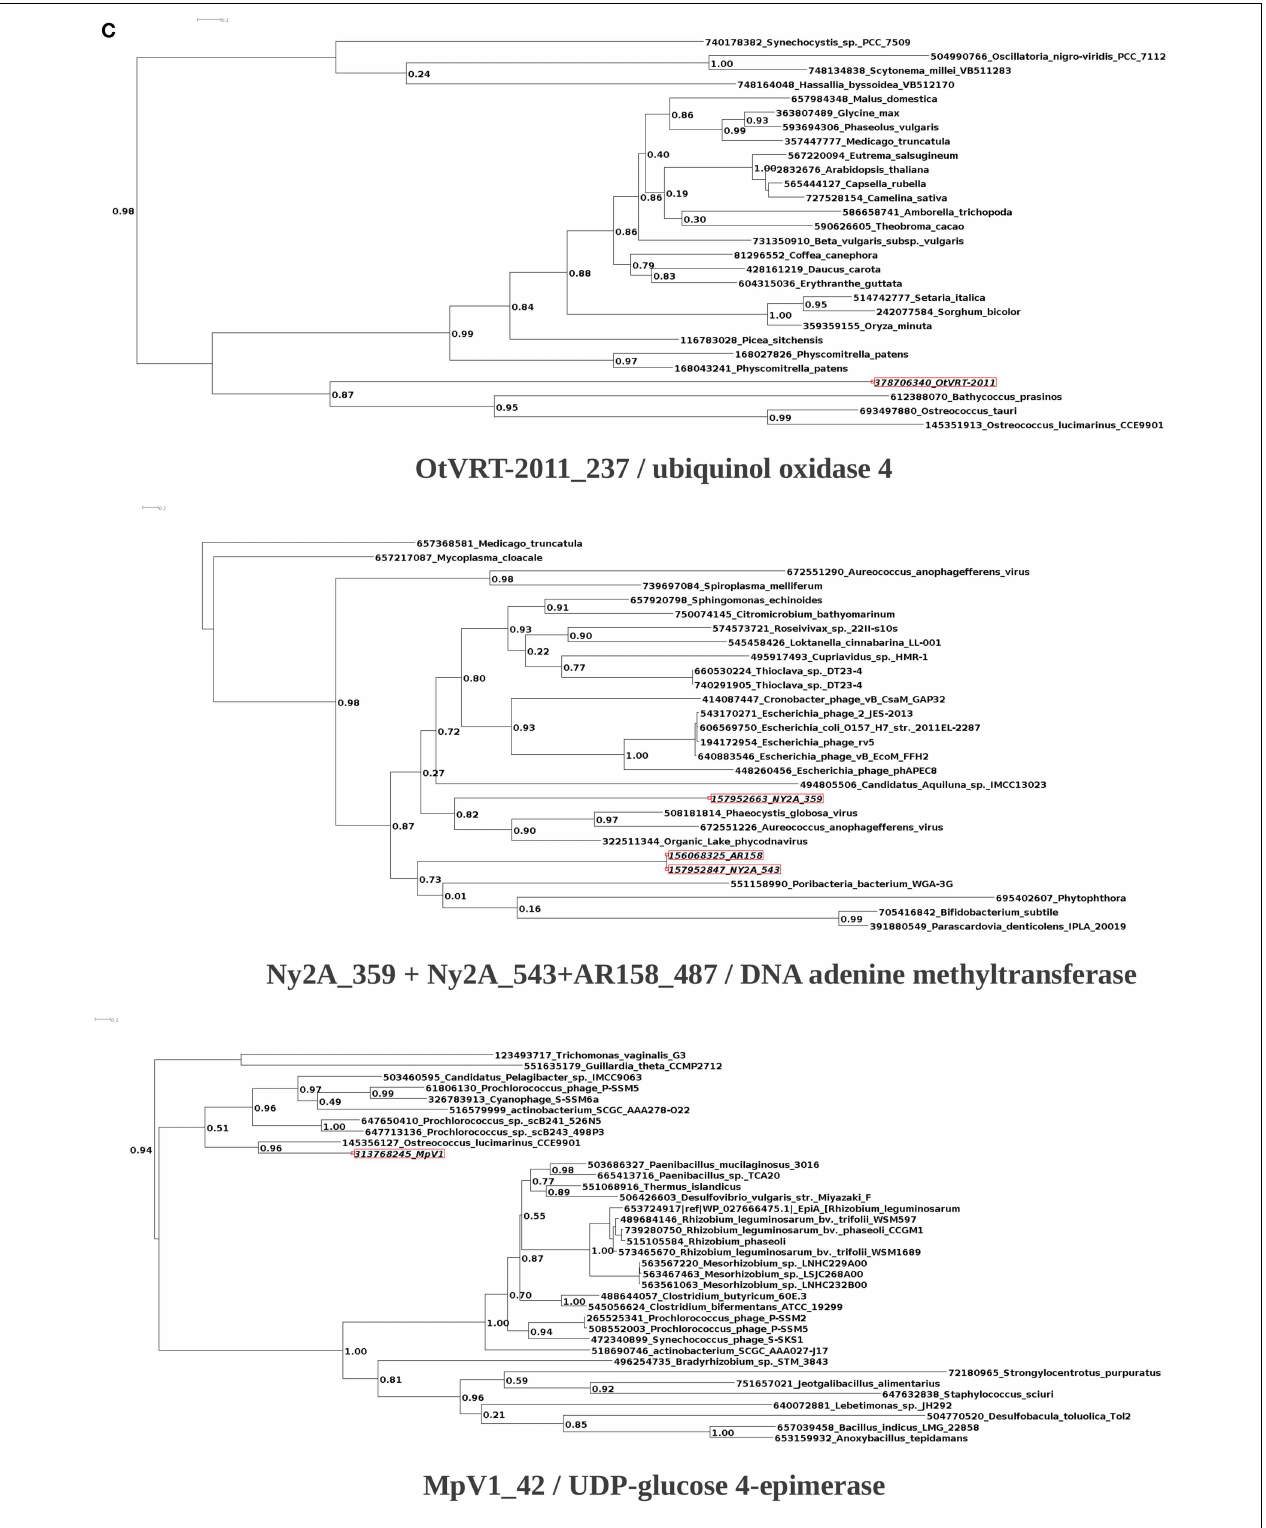
FIGURE 4 | Phylogenies of different cases of LGT encountered in GVs. (A) LGT from diverse Bacteria and Eukarya (B) LGT from the hosts. (C) LGT from ambiguous sources. Viral sequences have been framed in red. The numbers beside each node indicate the value of the SH-like statistical test.